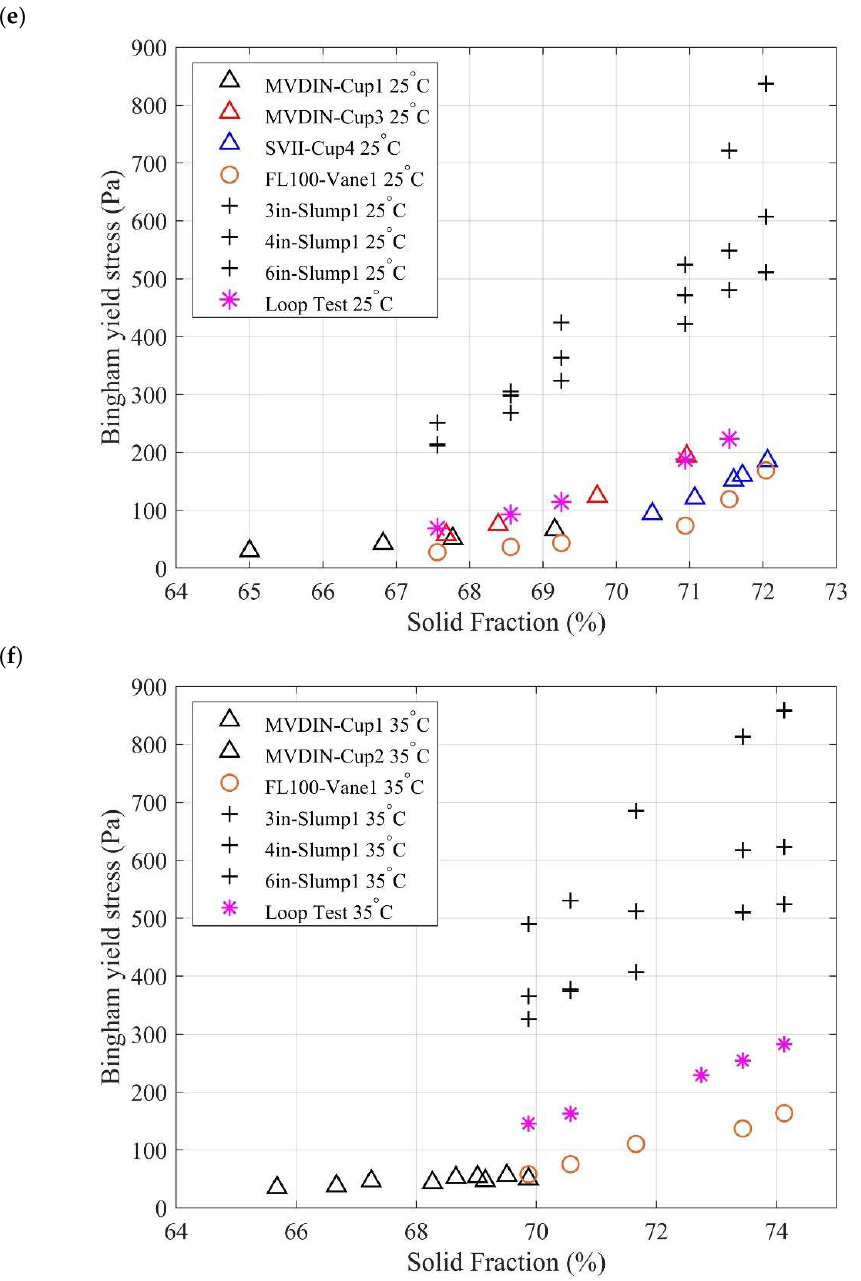
Figure 7. Bingham yield stresses for ( a ) Mine-A at 15 °C; ( b ) Mine-A at 25 °C; ( c ) Mine-A at 35 °C; ( d ) Mine-B at 15 °C; ( e ) Mine-B at 25 °C; and ( f ) Mine-B at 35